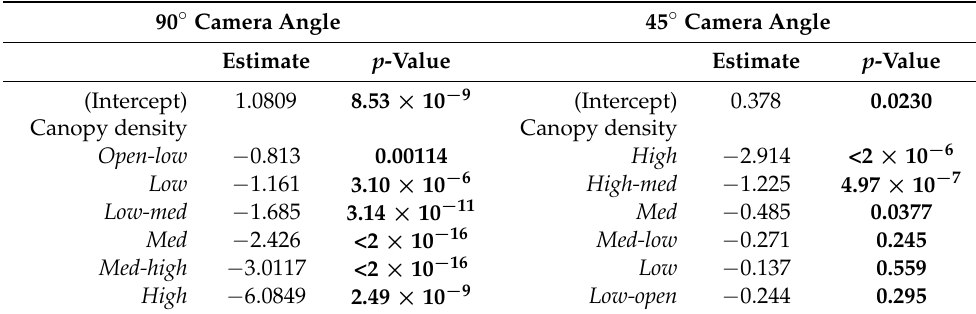
Table A4. A summary of coefficients and p -values showing the effect of canopy density on detection with different camera angles for RGB data with manual analysis.